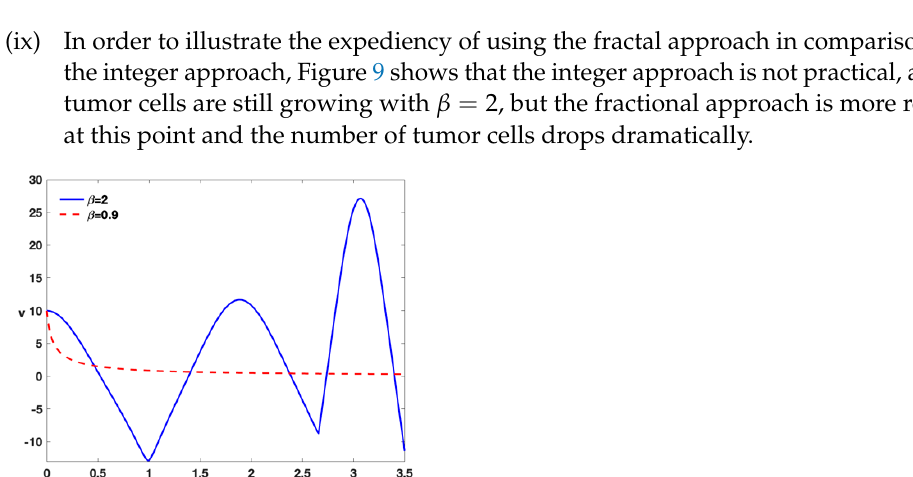
Figure 8. Phase diagram of equilibrium point